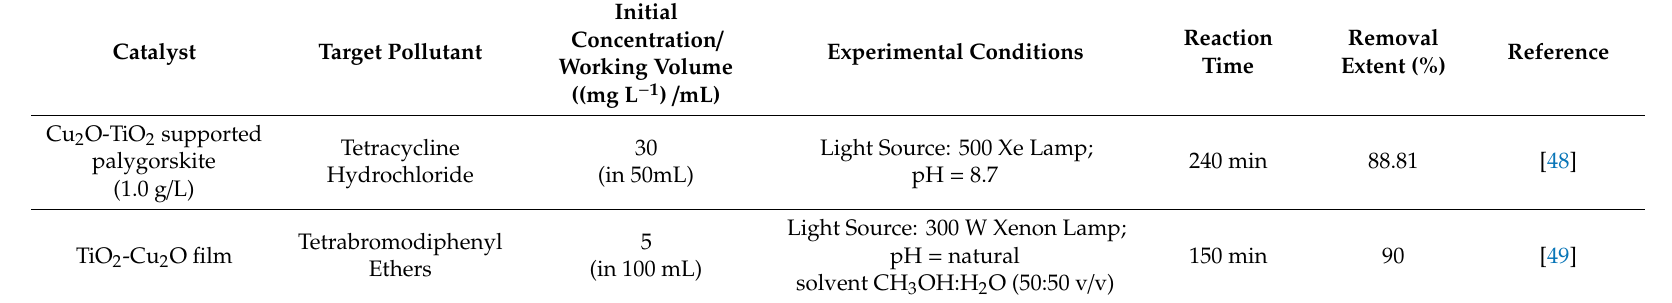
Table 4. Photocatalytic degradation of CEC’s over TiO 2 / Cu 2 O composites.